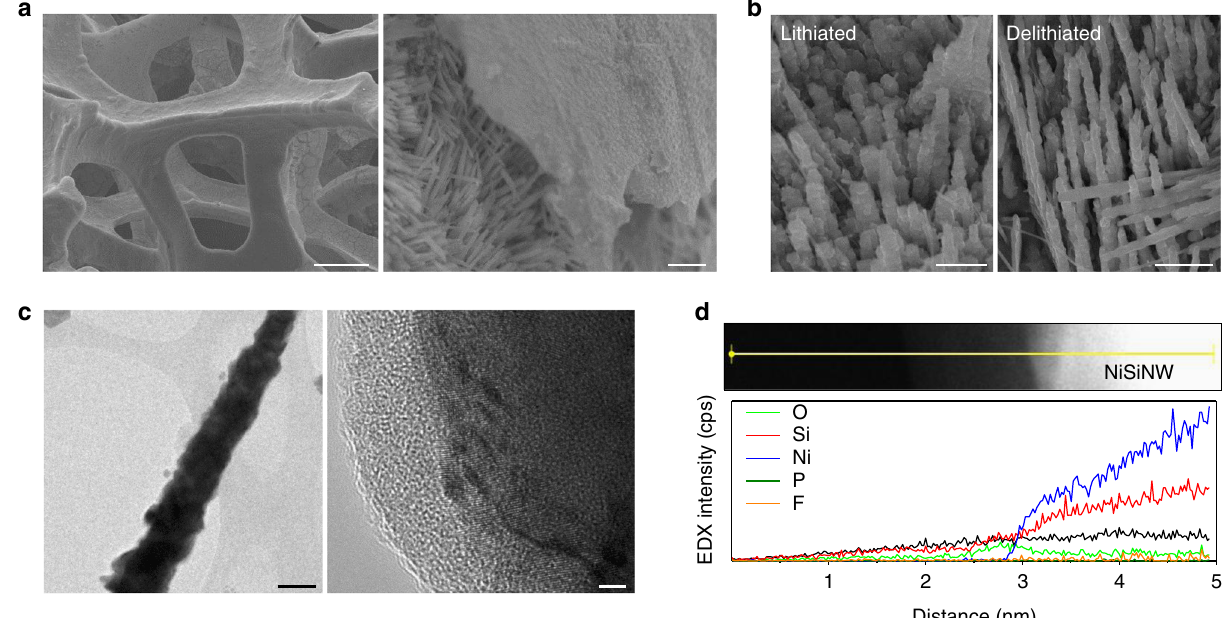
Fig. 4 Morphology and SEI formation of NiSiNWs@Gr μ T after cycling. a SEM image of delithiated NiSiNWs@Gr μ T after cycling. Close-up SEM image of the intentionally-fractured part of the NiSiNWs@Gr μ T (right), which shows near SEI-free NW surfaces inside the Gr μ T covered with a thick SEI layer. Scale bars, 100 μ m (left) and 2 μ m (right). b SEM images of the lithiated (left) and delithiated (right) NWs inside the Gr μ T (with the same magni fi cation). The diameter of the NWs increases by an average of 190% after lithiation. Scale bars, 1 μ m. c TEM image of delithiated NiSiNW after cycling (left) and enlarged HR-TEM images taken from the square in the left panel, showing the polycrystalline NiSi core covered with a 5-nm-thick oxide amorphous shell (right). 100 nm (left) and 2 nm (right). d EDS element analysis of delithiated NiSiNW, taken along the solid line in the upper panel of the dark- fi eld image of the NiSiNW and oxide region. SEI-related components (e.g., P and F) were not